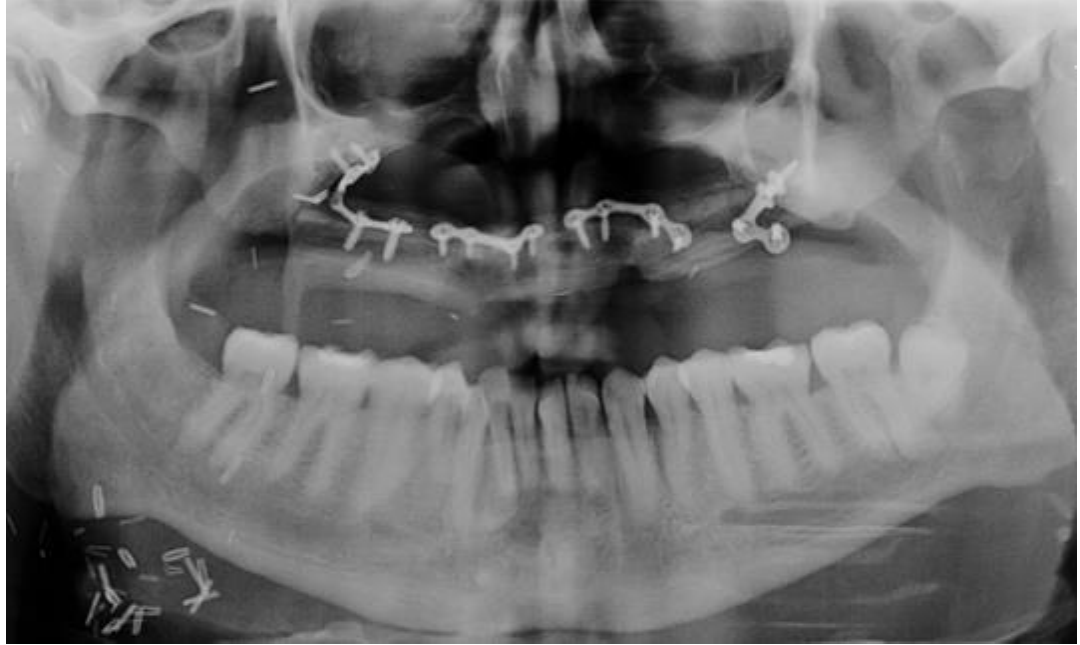
Figure 2. Patient after an upper jaw osteosarcoma resection and reconstruction with FFF. (19 De- cember 2018).